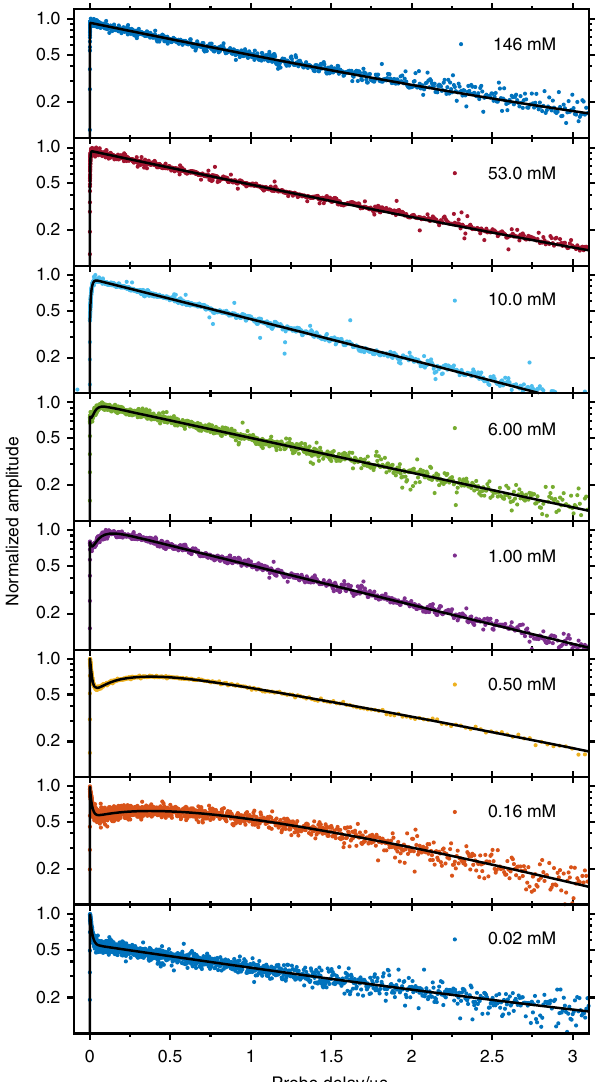
Fig. 4 Kinetic traces of triplet ESA at selected concentrations with respective fi t traces. The kinetic traces at a probing wavelength of 500 nm, that is, the maximum of the triplet ESA, are sensitive to the chromophore concentration. No µ s local maximum is visible for the lowest concentration (0.02 mM), as sequential SF and triplet decay occur at comparable rates. At higher concentrations, the S 0 sensitisation process is accelerated, which explains a local maximum on the µ s timescale and justi fi es the shift of that maximum towards shorter probe delays as the chromophore concentration is increased. For concentrations ≥ 10 mM, no maximum is visible as (i) the 1 O 2 sensitisation is the rate-limiting step and (ii) the rate of homogeneous SF surpasses the rate of sequential SF. Source Data are provided as